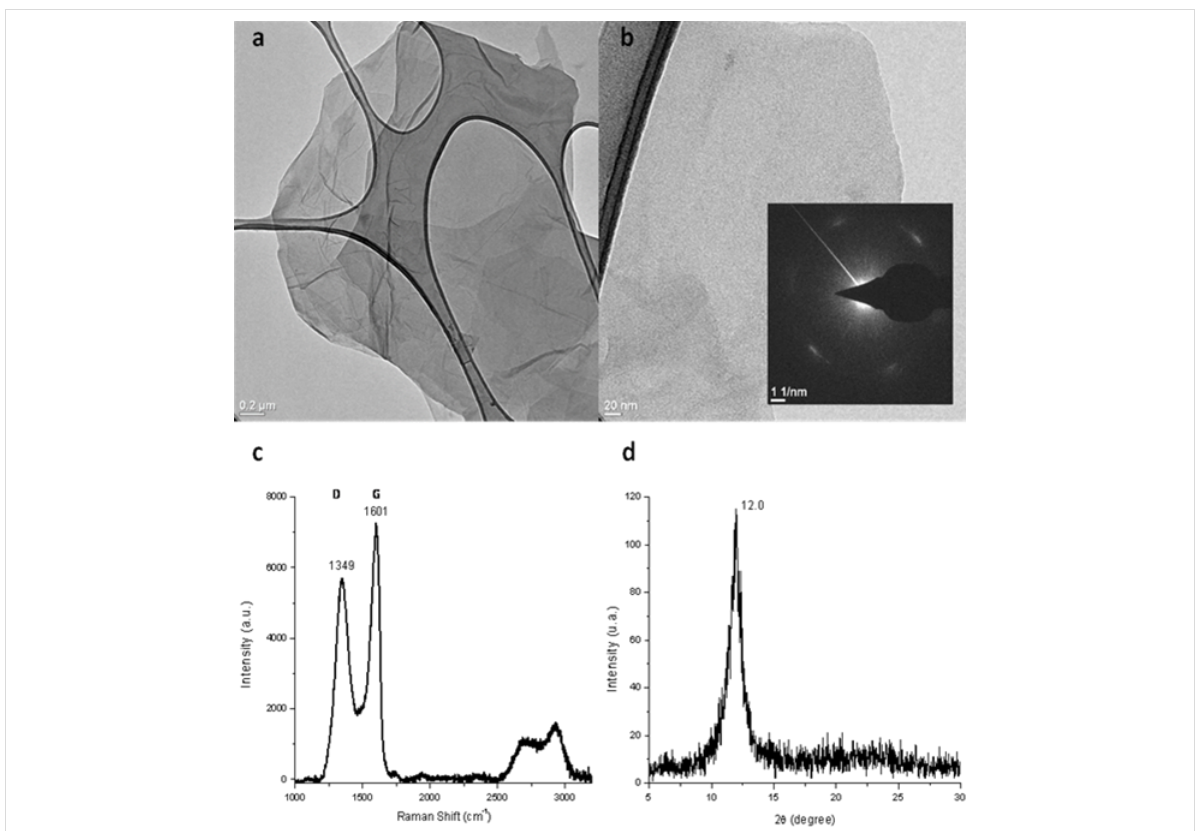
Figure 1: GO data; a) and b) TEM images of graphene oxide on lacey carbon, inset: SAED showing diffraction spots of hexagonal patterns; c) Raman spectrum with 532 nm excitation d) XRD pattern showing (002) with d = 0.737 nm.